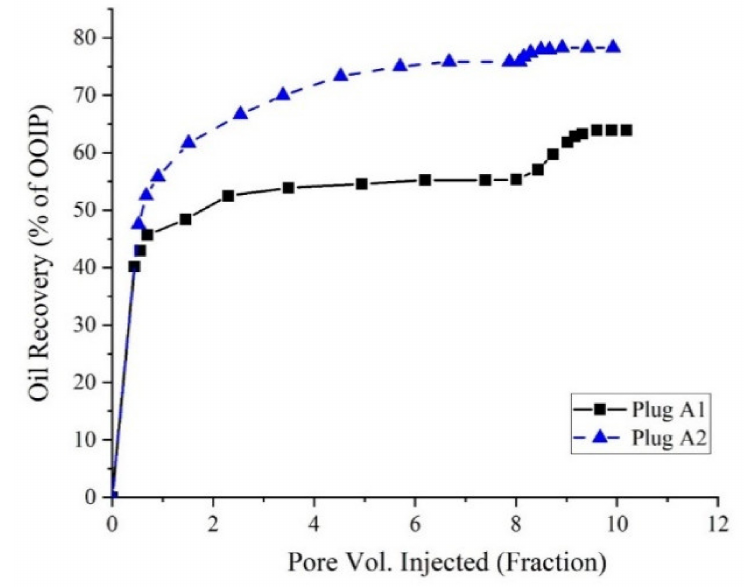
Figure 21. Oil recovered from the secondary and tertiary oil recovery